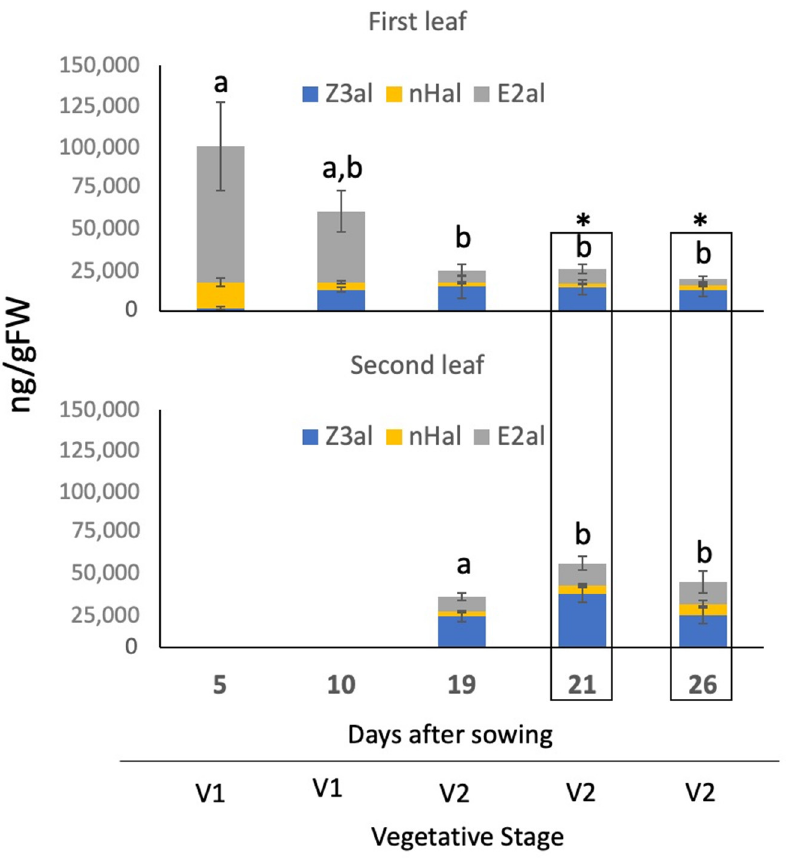
Figure 4. Distribution of the capacity to produce aldehyde GLV in developing mung bean ( Vigna radiata ) seedlings. Results for Z-3-hexenal (Z3al), n-hexanal (nHal), and E-2-hexenal (E2al) at different ages and their corresponding developmental vegetative stage are shown. The values are means ± SD, and different letters indicate significant differences (ANOVA, p ≤ 0.05) in the total amount of aldehyde GLV within one leaf. The asterisks indicate significant differences in the total amount of aldehyde GLV between the first and second leaf (Students t -test, p ≤ 0.05, marked by boxes).